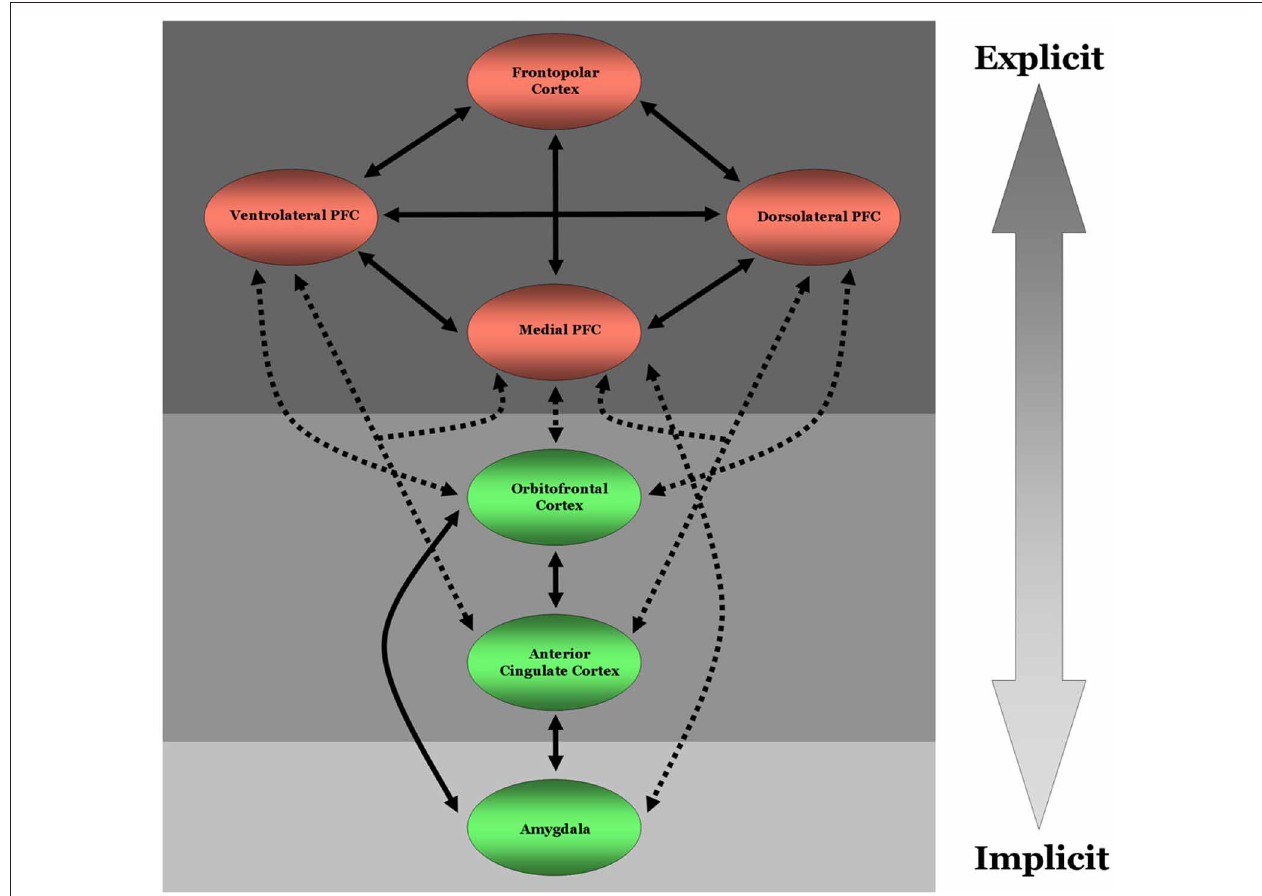
FIGURE 1 | Diagram of direct neural connectivity between regions critical for implicit and explicit social cognitive and moral judgment processes. Solid bi-directional arrows denote direct reciprocal neural connectivity between two regions within a given processing system, i.e., implicit or explicit processing. Dashed bi-directional arrows represent direct reciprocal connectivity between two regions typically involved in either implicit or explicit processing. Green colored circles denote neural regions that are typically involved in more implicit cognitive processing. Red colored circles signify neural regions that are typically involved in